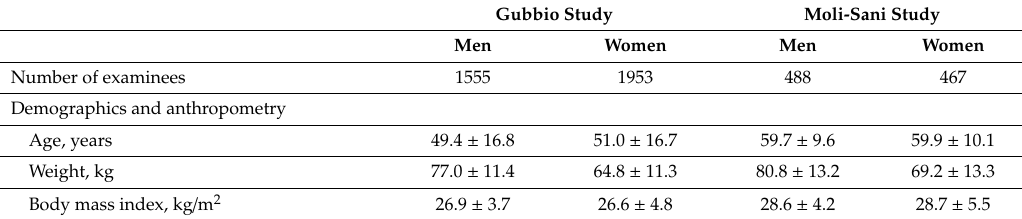
Table 1. Descriptive statistics in the Gubbio study dataset and the Moli-sani study dataset: prevalence, mean ± SD for numerical non-skewed variable, and median (IQR) for numerical skewed variables ˆ. Gubbio Study Moli-Sani Study Men Women Men